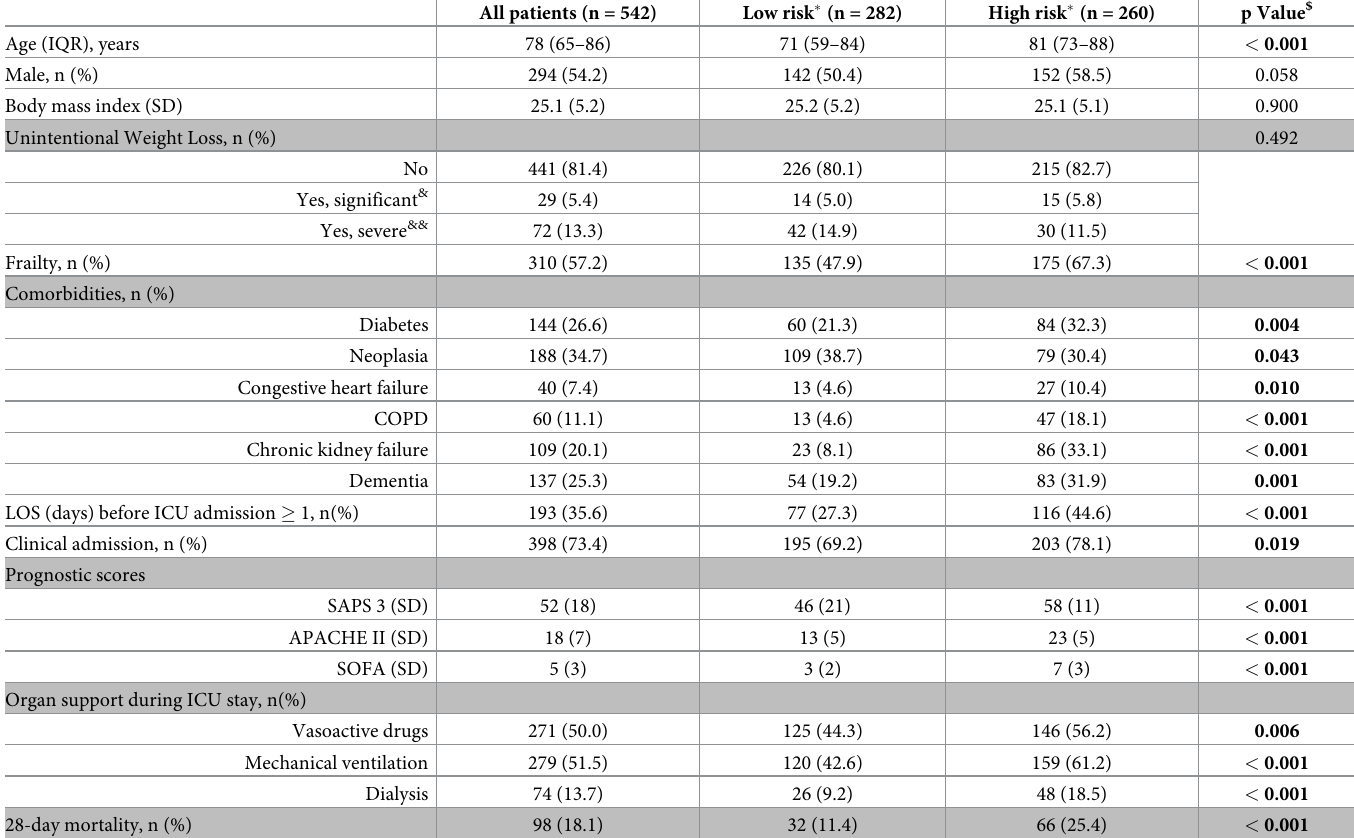
Table 1. Patient’s characteristics of included patients and stratified by NUTRIC score. All patients (n = 542) Low risk � (n = 282) High risk � (n = 260) p Value $ 78